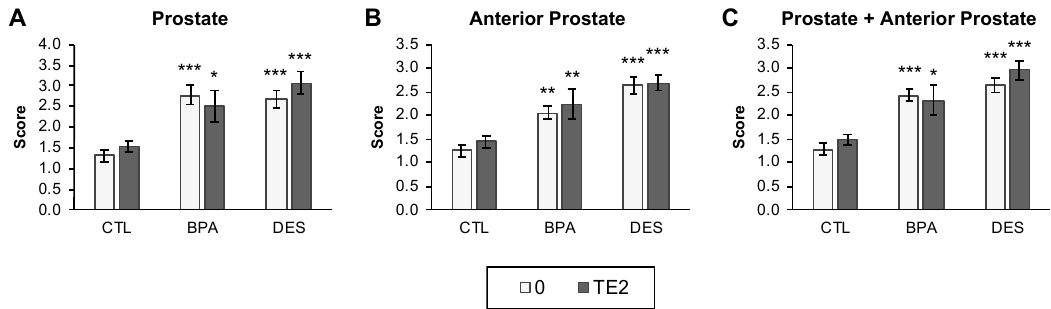
Figure 5. Assessment of prostate size (conducted blind) by observational grading. ( A ) Prostate size (dorsal, lateral, and ventral lobes), ( B ) anterior prostate size, and ( C ) size of the combined prostate and anterior prostate. Values are mean ± SEM of scores using a 4-point scale similar to that used for the bladder (see Figure 1 and Methods). * P < 0.05, ** P < 0.01, *** P < 0.001 vs. control males (CTL-0).